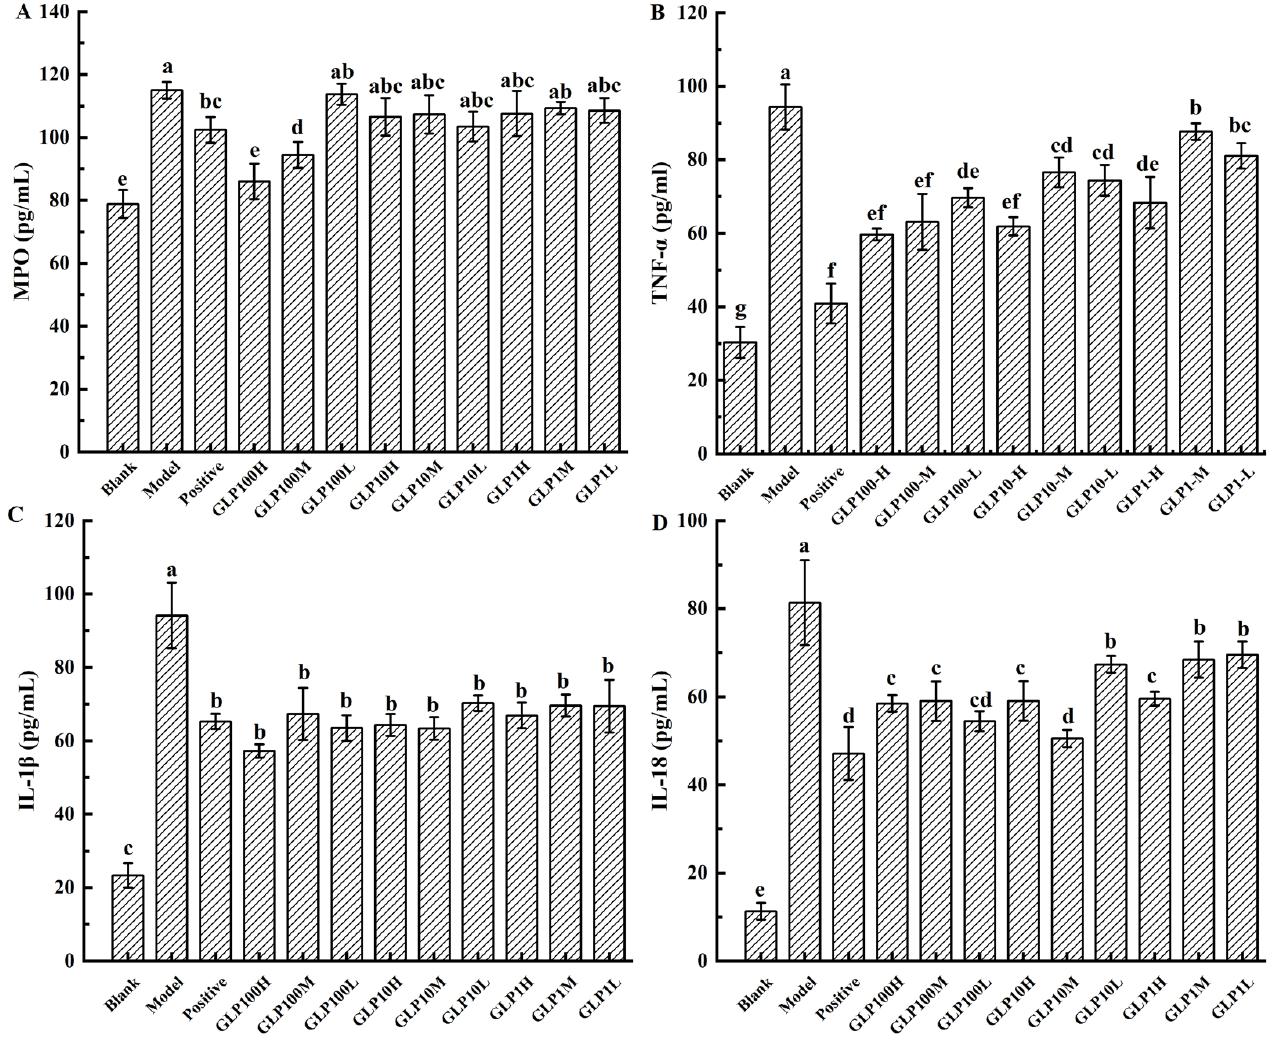
Figure 5. Effect of GLPs on the contents of MPO ( A ), TNF- α ( B ), IL-1 β ( C ), and IL-18 ( D ) in rats. Different lowercase letters (a–f) indicate significant differences at p <